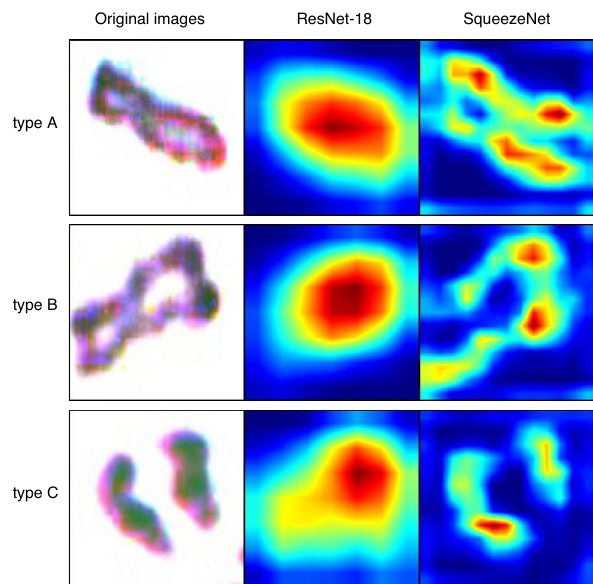
Figure 4. Visualization of the focus of each model with